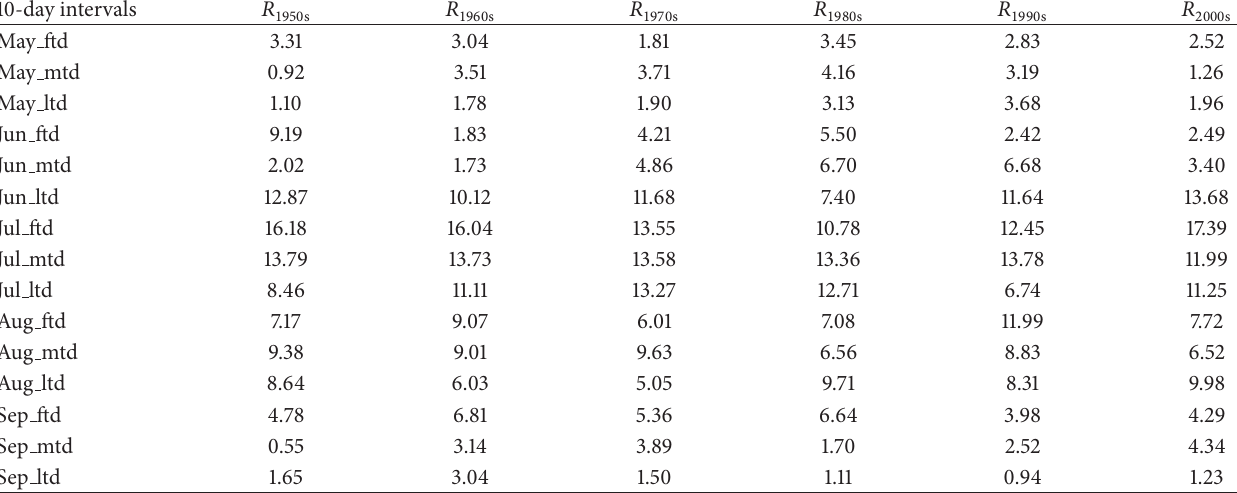
Table 2: Contribution rate of rainstorm events and their start times based on 10-day intervals, in